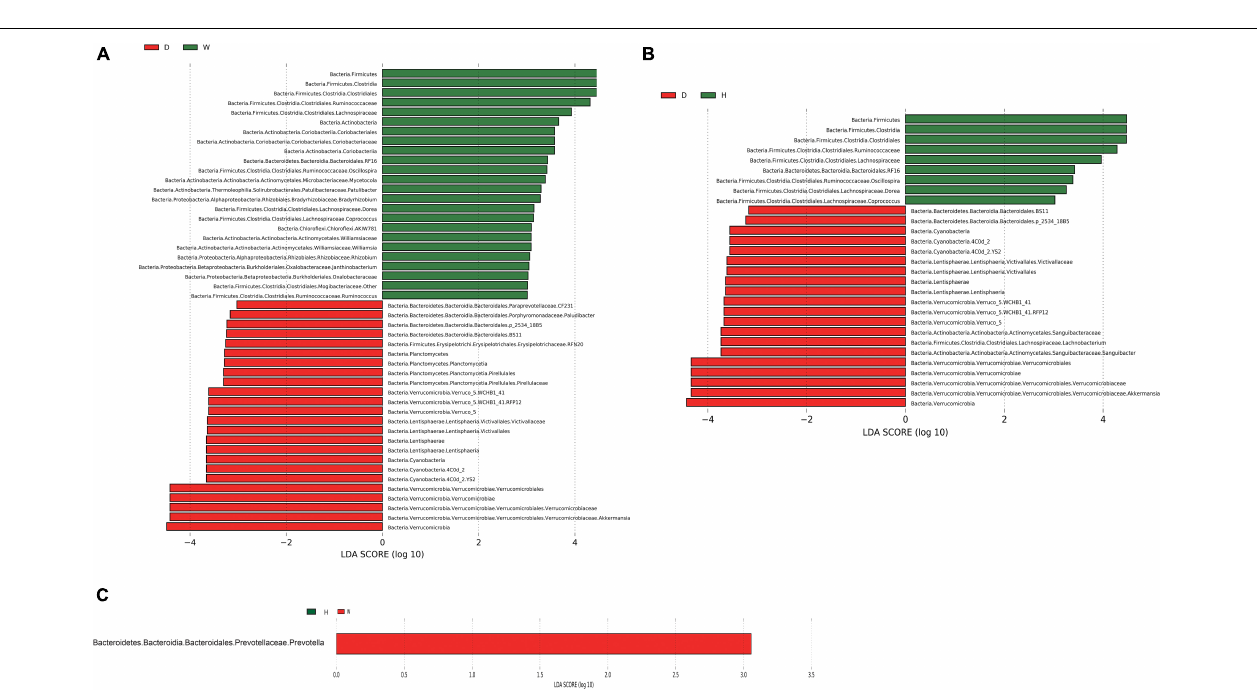
FIGURE 3 | The linear discriminant analysis effect size (LEfSe) shows the significantly different taxa of the gut microbiota between the different groups at the genus level ( LDA scores > 3.0, p < 0.05); the letters “D,” “H,” and “W” represent domestic, half-blood, and wild yaks, respectively. (A) The significantly different taxa between domestic and wild yaks. (B) The significantly different taxa between domestic and half-blood yaks. (C) The significantly different taxon between half-blood and wild yaks.